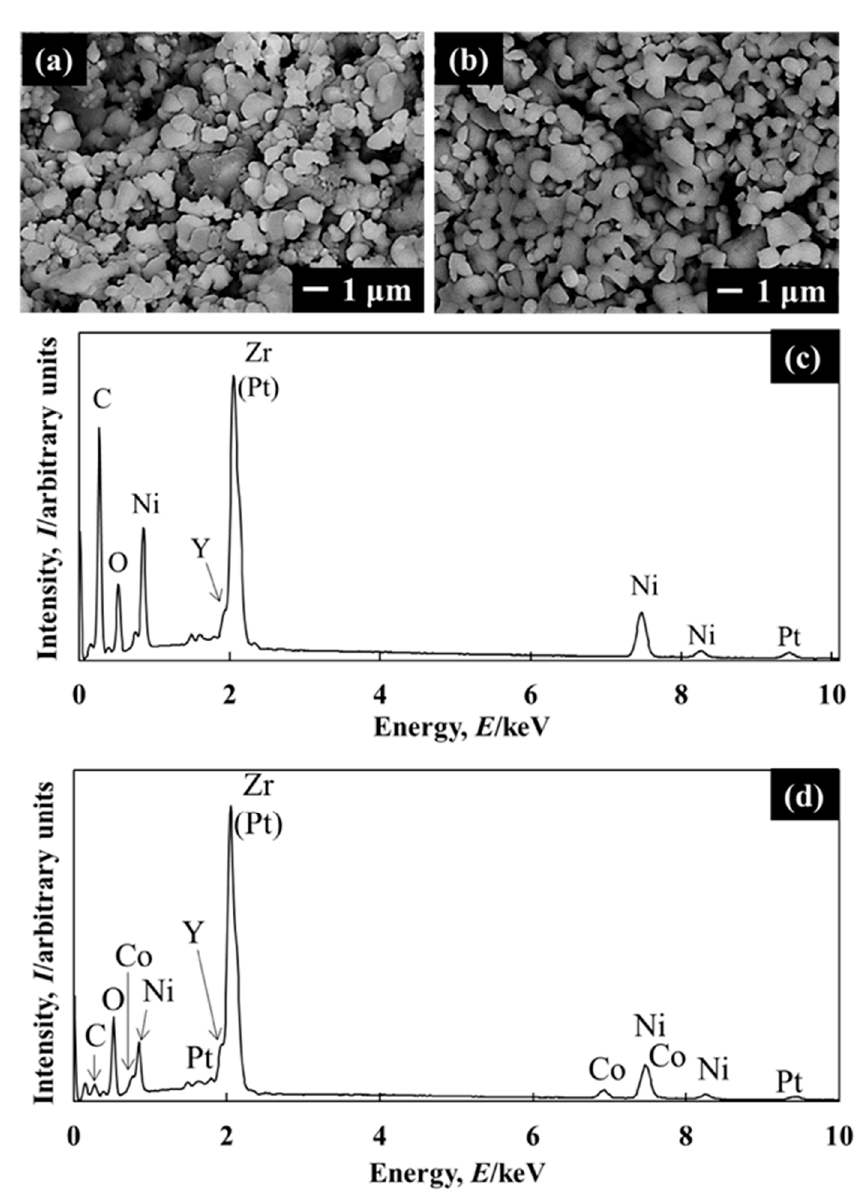
Figure 7. SEM micrographs of the anode surface for ( a ) the Ni cell ( b ) the Ni 0.85 Co 0.15 cell, and the corresponding EDX spectra of ( c ) the Ni cell (d) the Ni 0.85 Co 0.15 cell after the prolonged test at 750 °C for 60 h in CH 4 .